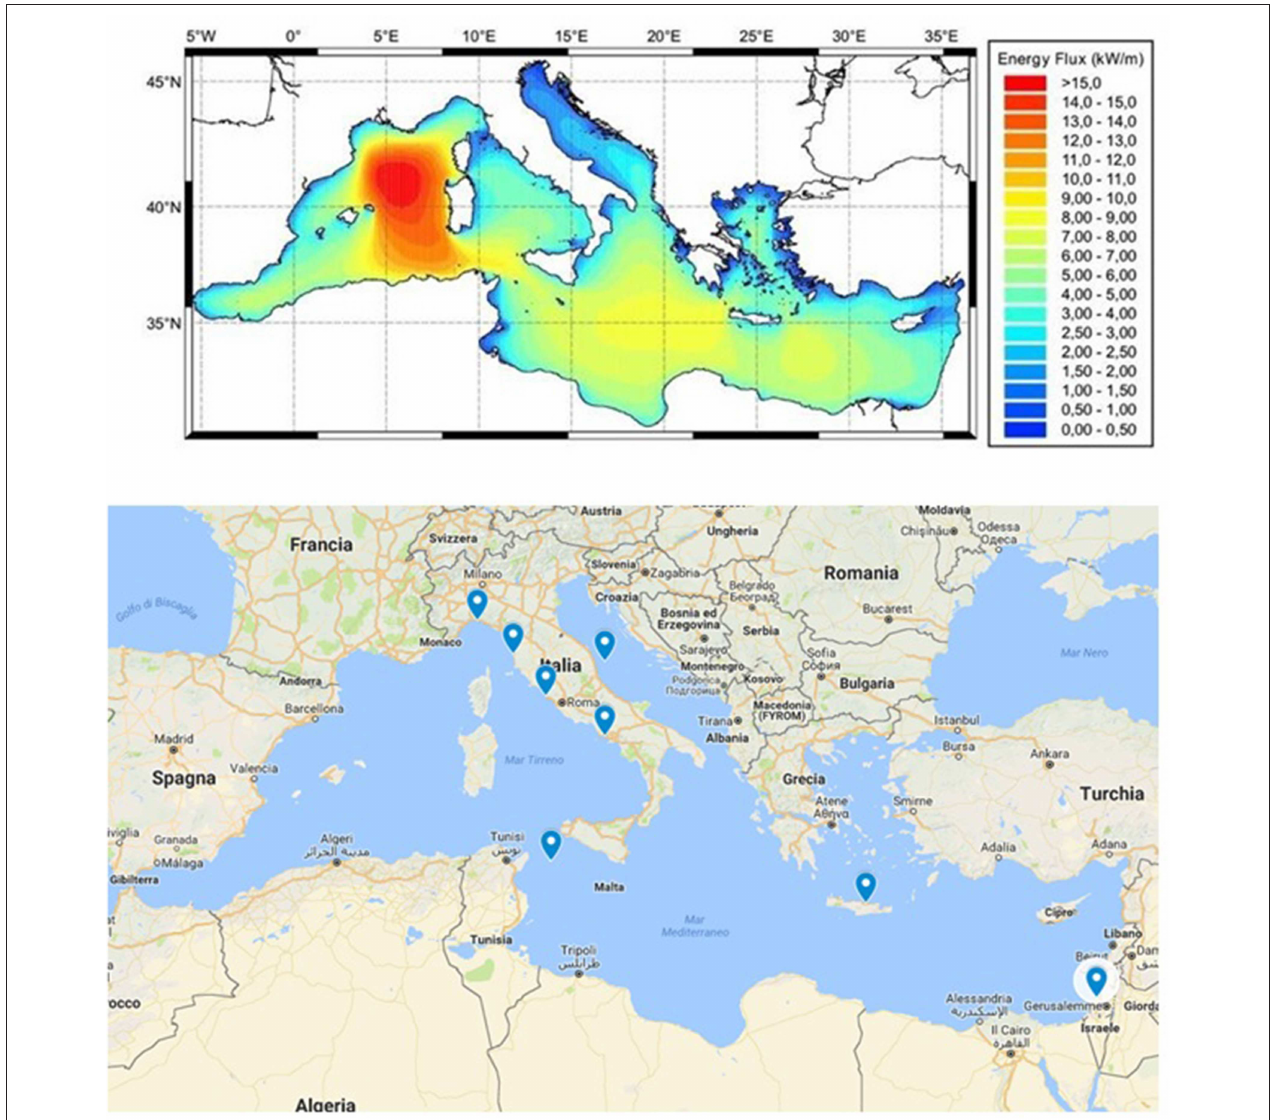
FIGURE 1 | Mediterranean wave resource (Top) and Map of Mediterranean showing the places where the projects took place (Bottom) . Map data © 2018 GeoBasis-DE/BKG ( © 2009), Google, Inst. Geogr. Nacional, Mapa GISrael,